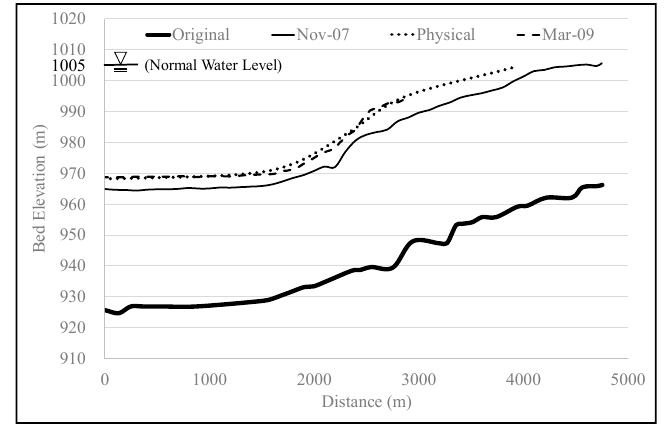
Figure 5. Longitudinal bed elevation of the physical model and field-measured data.